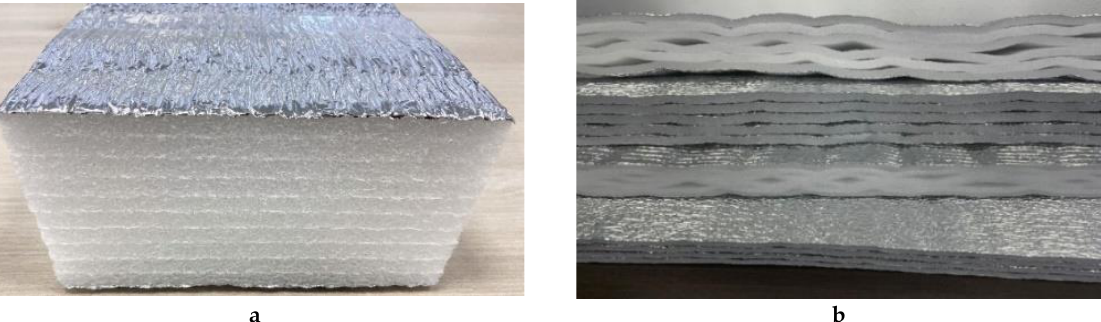
Figure 1. Products made of polyethylene foam: ( a ) — layered products; ( b ) — multilayer products with an air gap of the AirLayer line.